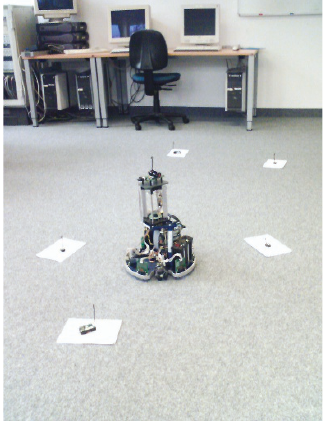
Figure 3: Setup of the lab